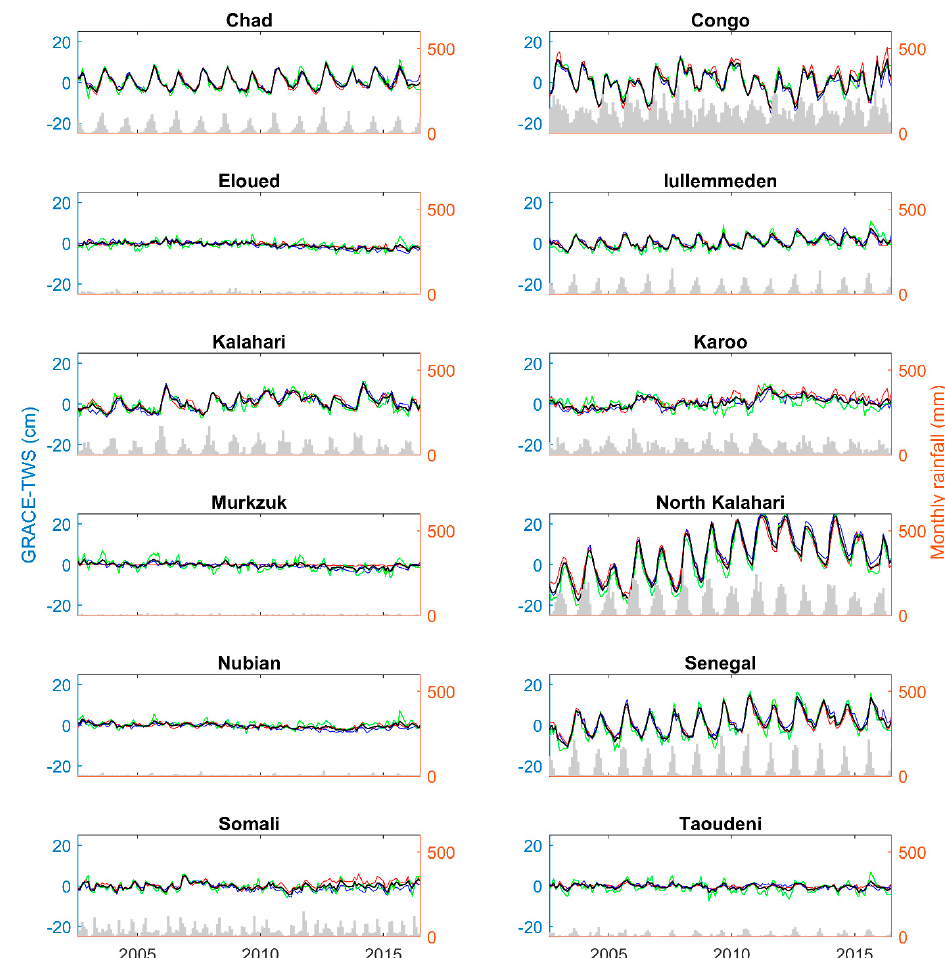
Figure 2. Terrestrial water storage (TWS) anomalies (cm) for each of the major aquifer basins across Africa. The ensemble GRACE product is shown in black; the Centre for Space Research (CSR) product in red, the Jet Propulsion Laboratory Global Mascon solution (JPL-MSCN) product in blue, and the Centre National D’études Spatiales (CNES) Groupe de Recherches de Géodésie Spatiale product (GRGS) in green. Monthly rainfall from the Tropical Rainfall Measuring Mission (TRMM) is also shown.